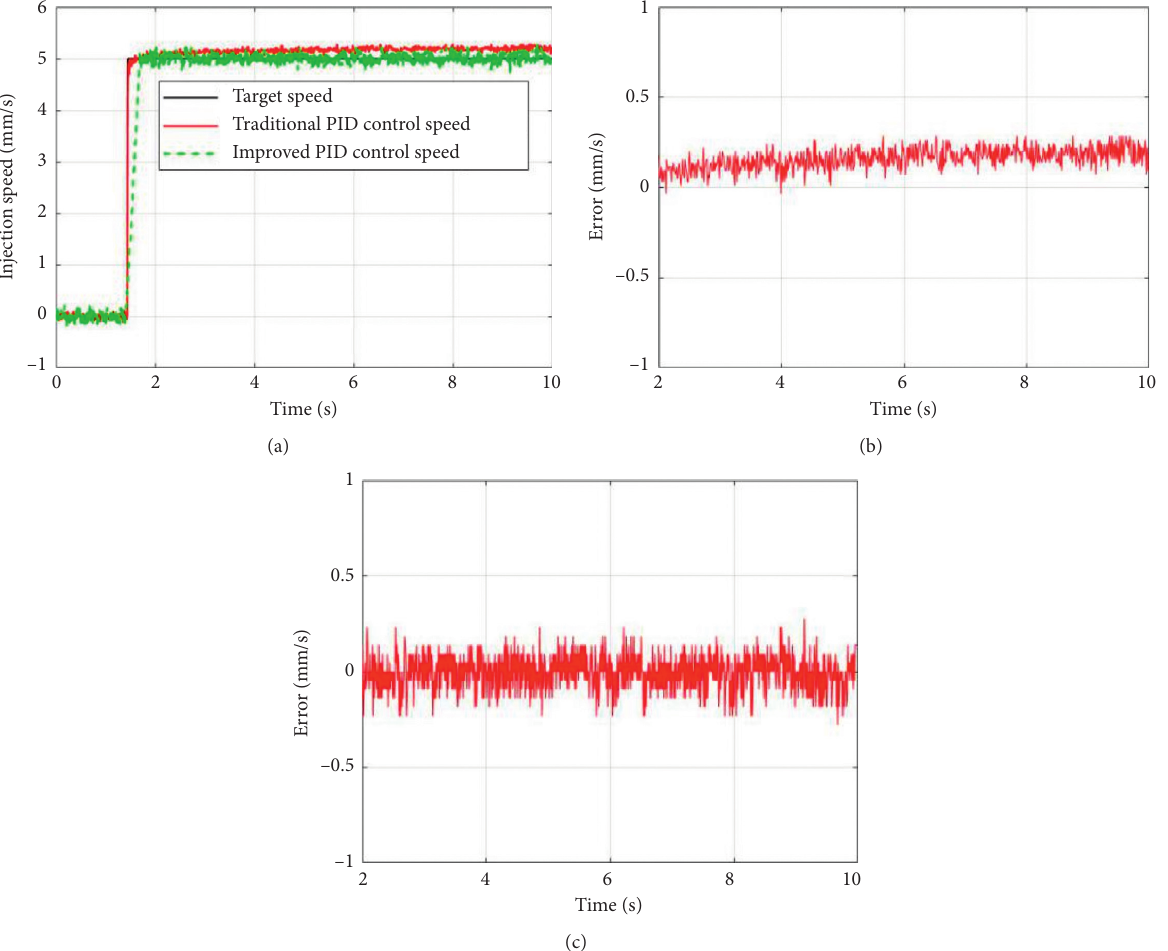
Figure 9: Step response test. (a) Comparison of three speed curves. (b) The error of traditional PID control. (c) The error of improved PID